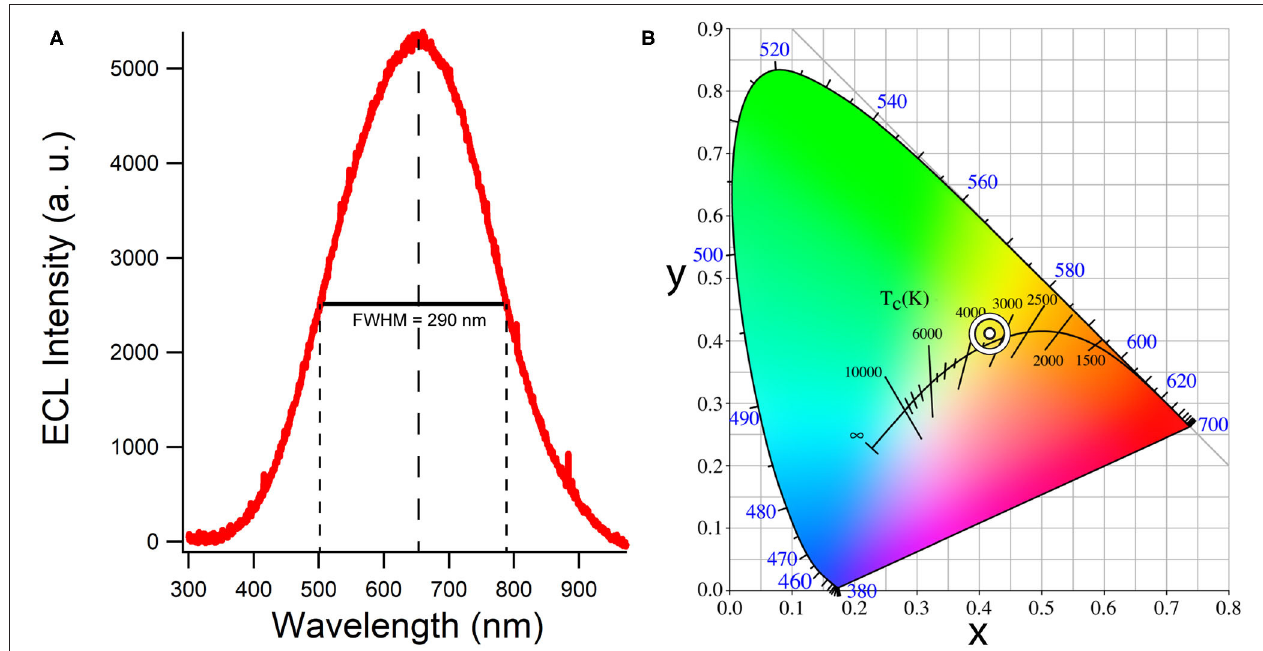
FIGURE 6 | (A) A background-subtracted accumulation of all light emitted during the same cyclic voltammogram of the system described in Figure 5 . Full-width half maximum is displayed as well as the main emission wavelength. (B) The corresponding CIE color space co-ordinates and correlated color temperature.